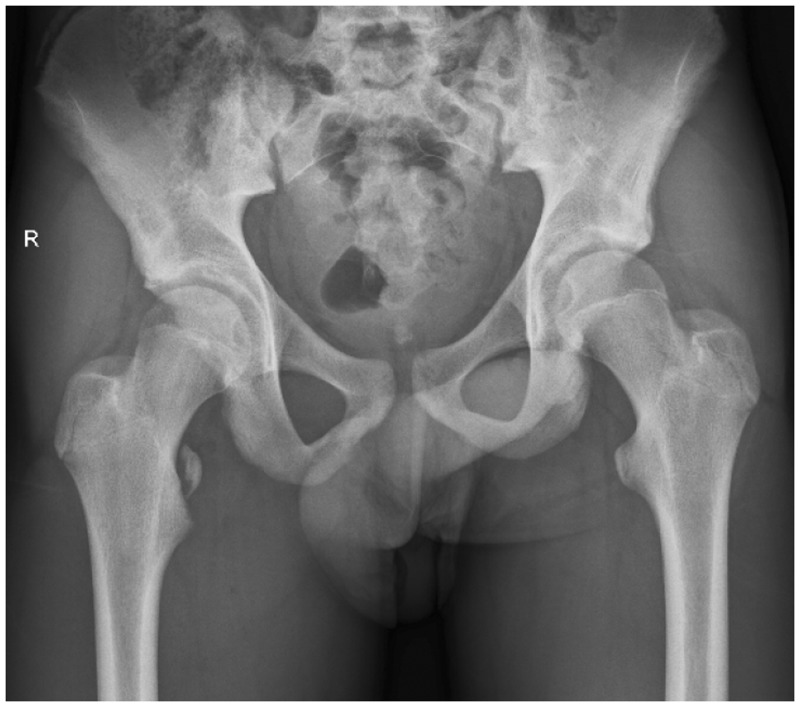
Plain radiograph showing an avulsion of the right lesser trochanter.